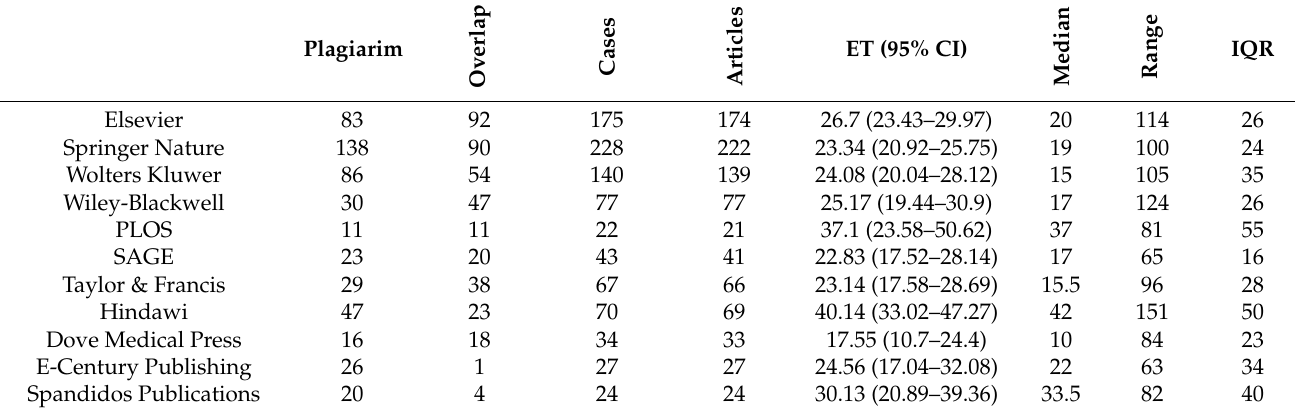
Table 10. Exposure time (ET) for plagiarism and overlap.